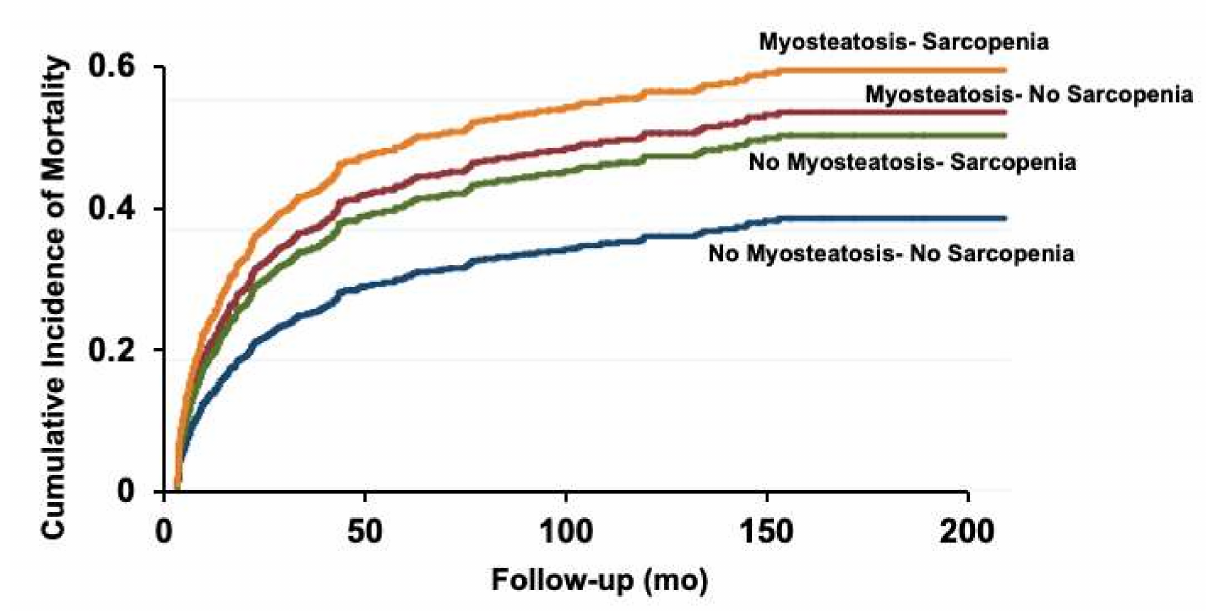
Figure 3. Cumulative incidence (Fine and Gray) of pre-liver transplant mortality in patients with various myosteatosis and sarcopenia